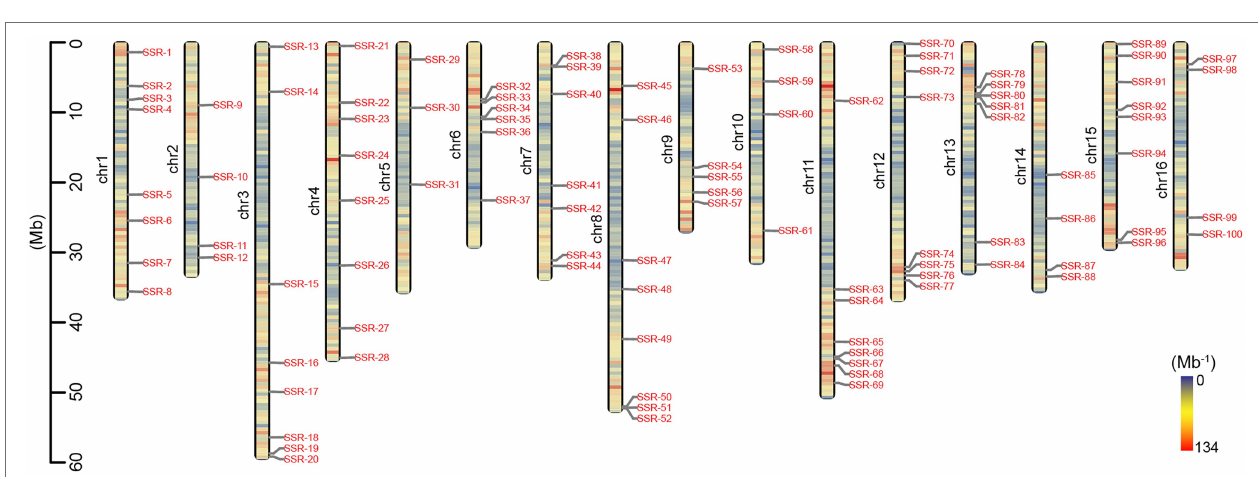
FIGURE 3 | Distribution of high-polymorphism-potential (HPP) SSR markers on the physical map of Akebia trifoliata . The left axis displays the length of chromosomes (Mb), and the color depth on the chromosomes represents the density of HPP markers (Mb − 1